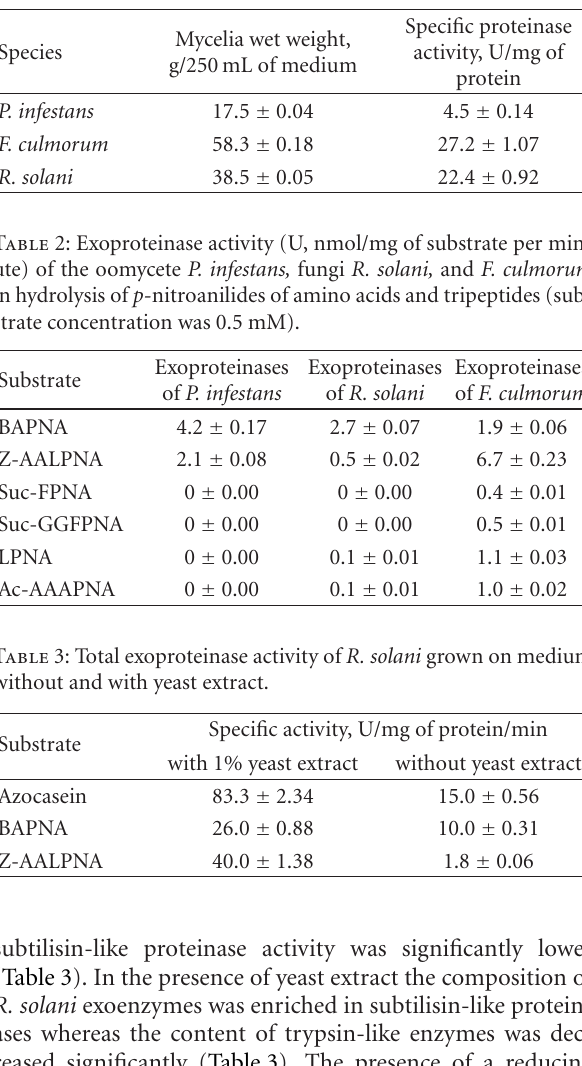
Table 1: Proteinase activities secreted by the three species studied in azocasein assay.